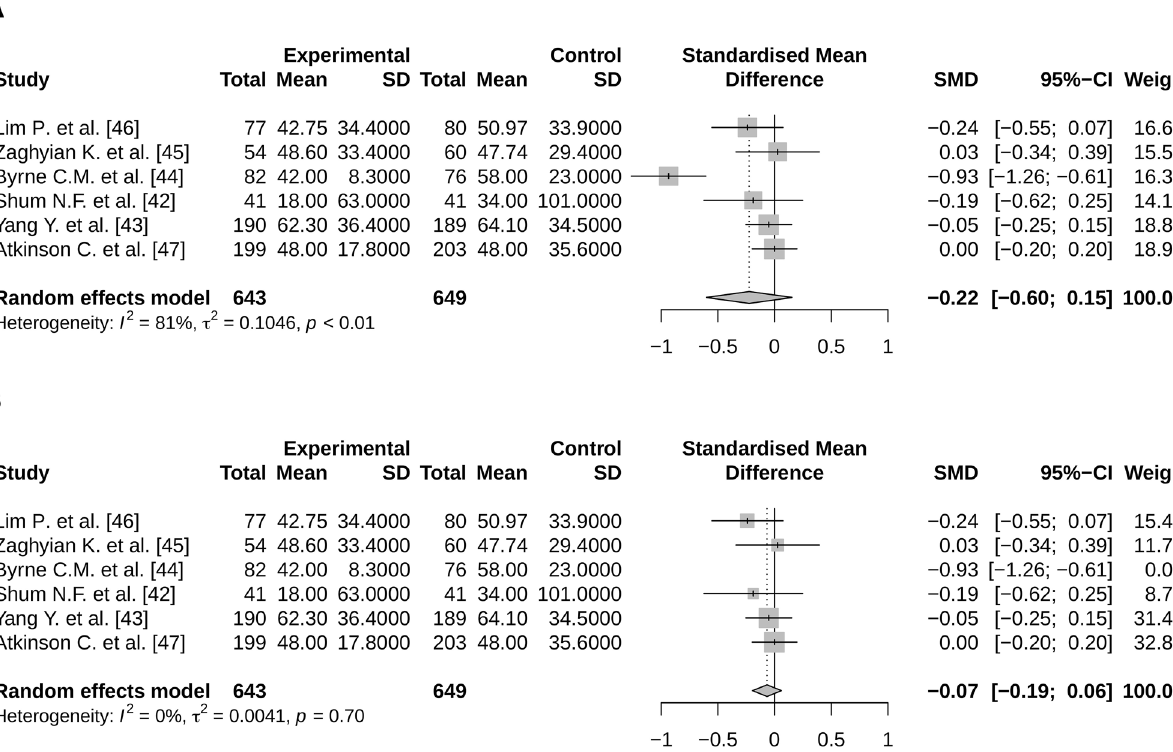
Figure 4. Meta-analysis of the time to first flatus according to a treatment by chewing gum ( A ) with and ( B ) without the outlier; (R software, 3.6.3, https:// www.R- proje ct.